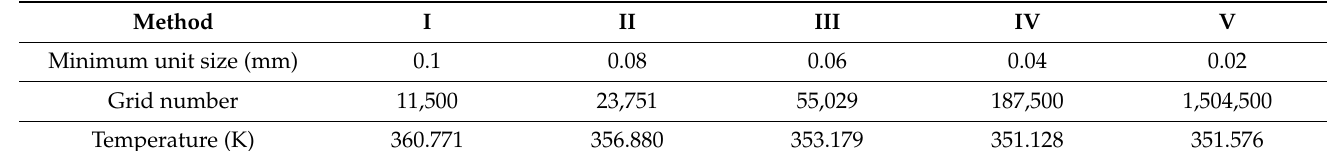
Table 2. Five meshing methods and simulation results.